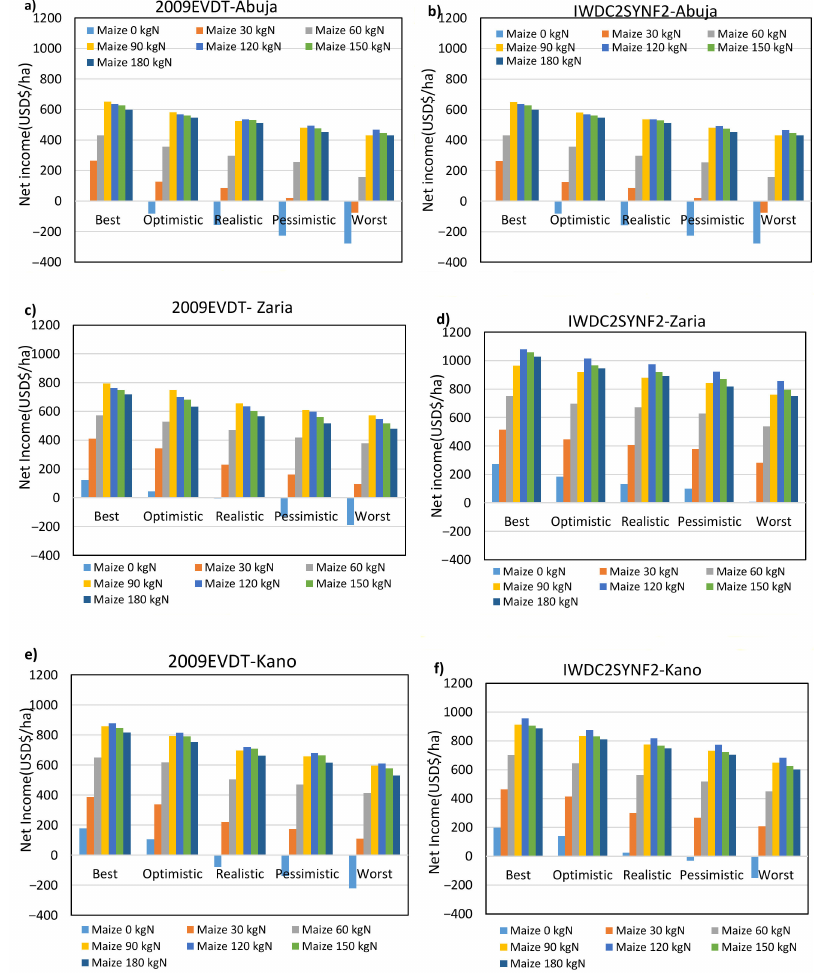
Figure 6. ( a – f ) - Scenario analysis of net income of maize yield (2009EVDT and IWDC2SYNF2) simulated under different N–fertilizer rates in the Abuja, Zaria and Kano representing SGS, NGS and SS agro-ecological zones of Nigeria (1 USD = 359.99